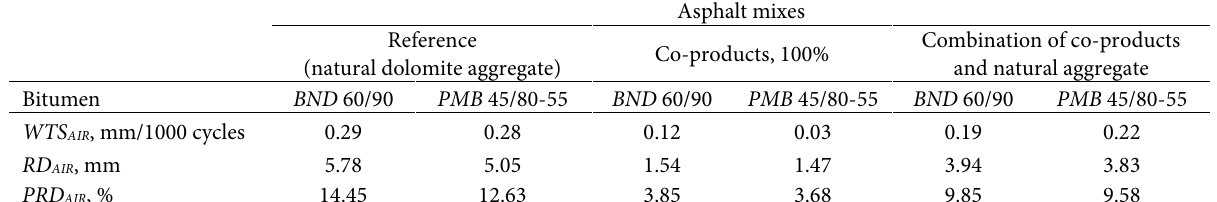
Fig. 5. Wheel tracking test curves Table 5. Characteristics of wheel tracking test